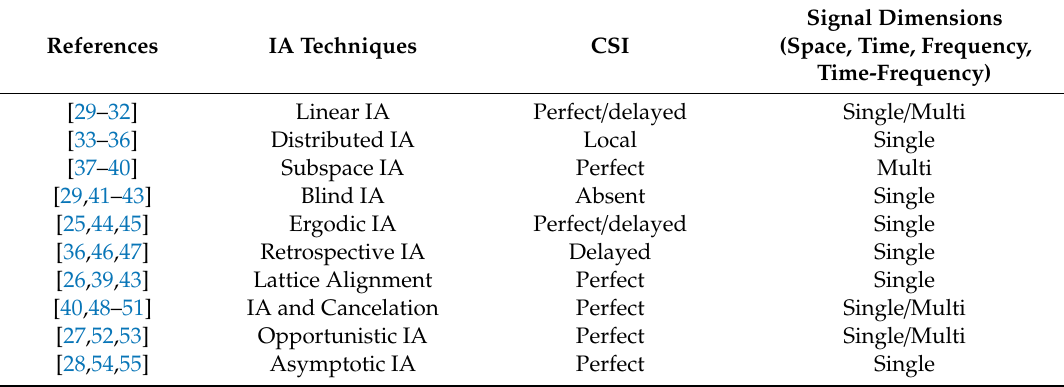
Table 2. List of general IA